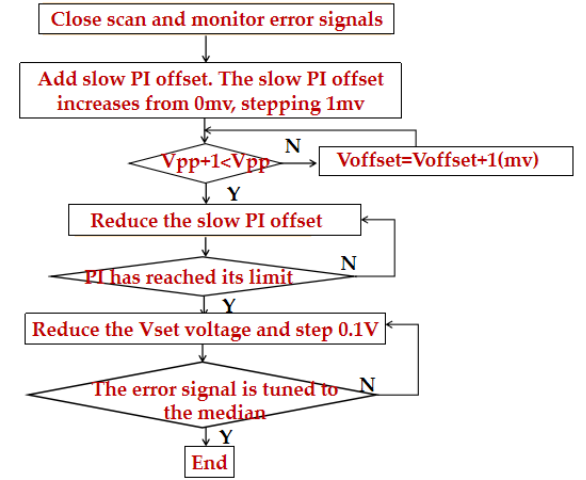
Figure 5. Flowchart of the optimization of the resonance peak.